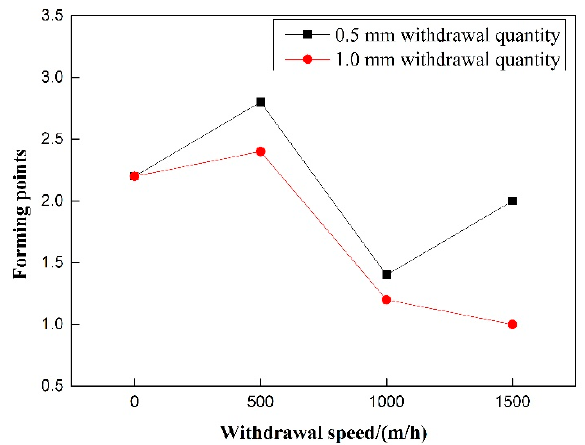
Figure 12. Effect of withdrawal speed on weld forming under different withdrawal quantity. Figure 12. E ff ect of withdrawal speed on weld forming under di ff erent withdrawal